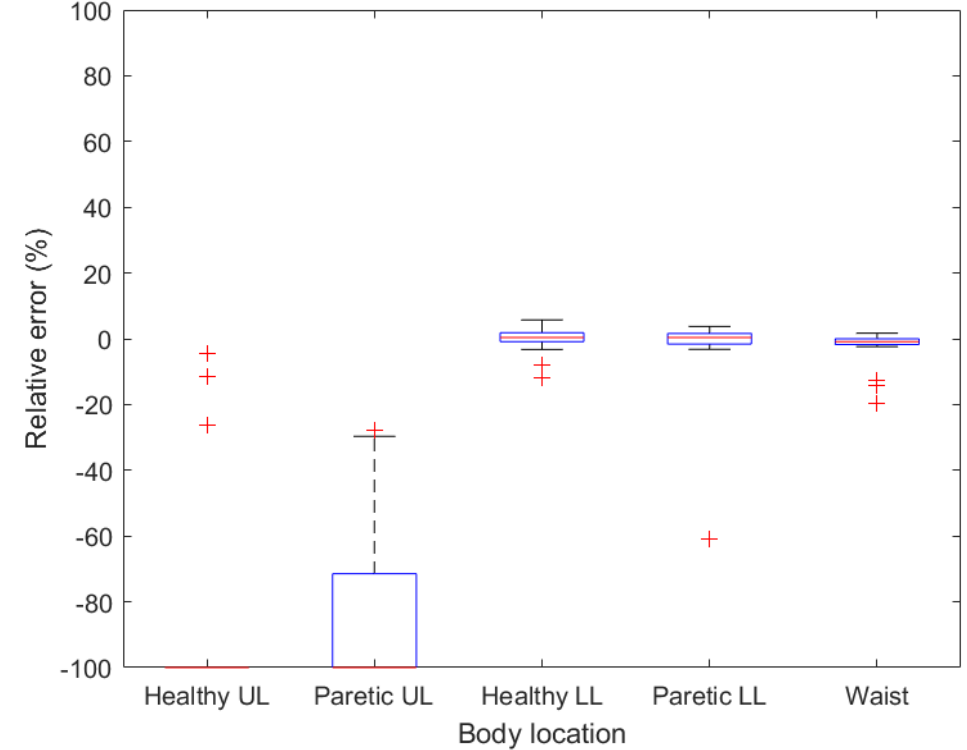
Figure 6. Boxplots demonstrating relative error for given body location when rolling walker is used. UL—upper limb, LL—lower limb.